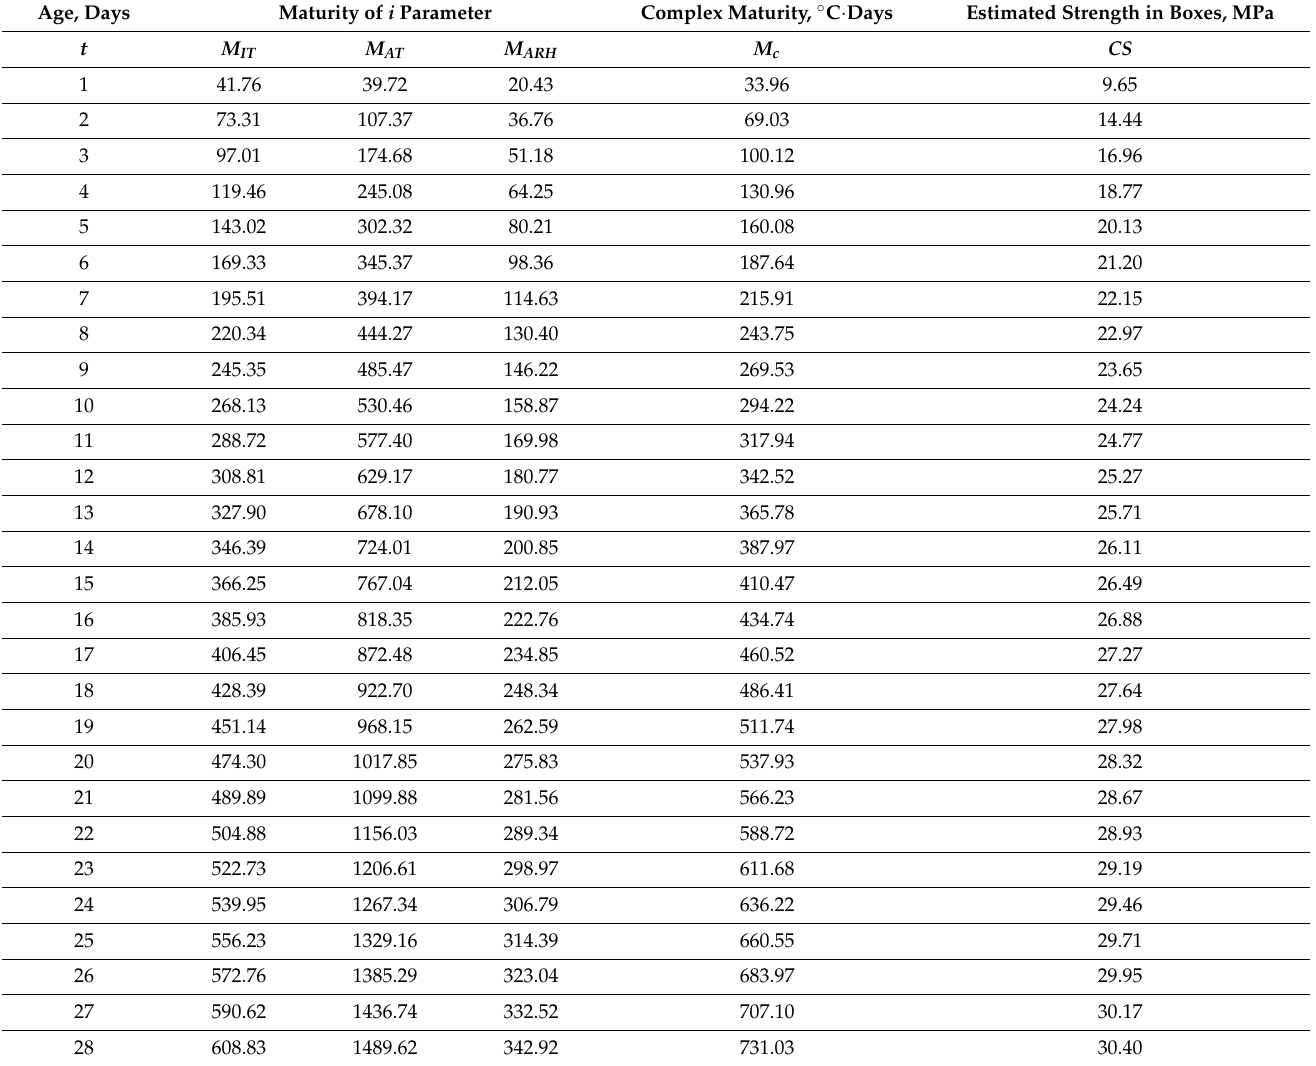
Table 4. Calculation of complex maturity–strength relationship and the strength of